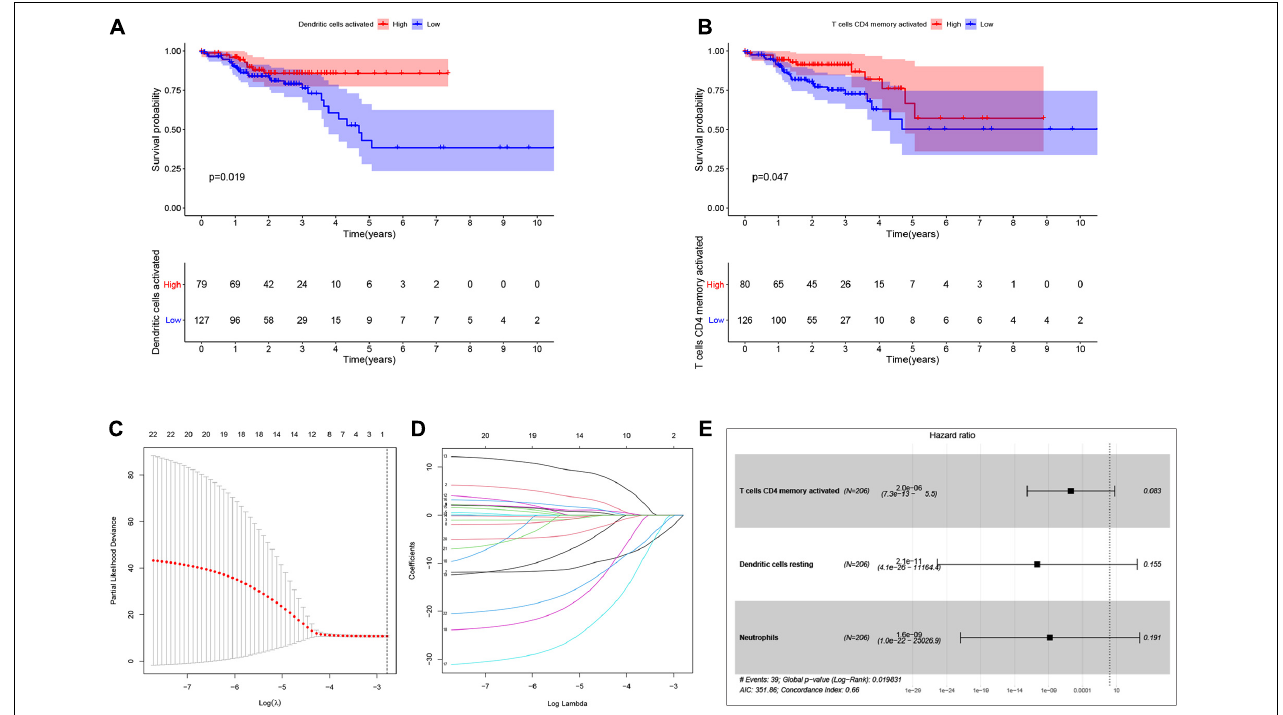
FIGURE 9 | Identification of the prognostic related infiltrating immune cells and establish a prognostic model. Kaplan-Meier analysis was performed to identify survival probability of patients with different activation of Dendritic and T cells CD4 memory (A,B) . Lasso regression was conducted to identify prognostic related Tumor infiltrating immune cells. Lasso coefficient profiles of the 22 Tumor infiltrating immune cells. Partial likelihood deviance of variables revealed by the Lasso regression model (C,D) . Multivariate Logistic regression analysis of infiltrating immune cells. p < 0.05 indicates a significant correlation between genes and prognosis, HR value > 1 means that the immune cells infiltrating is a high-risk gene, and HR < 1 means a low-risk immune cells infiltrating (E)